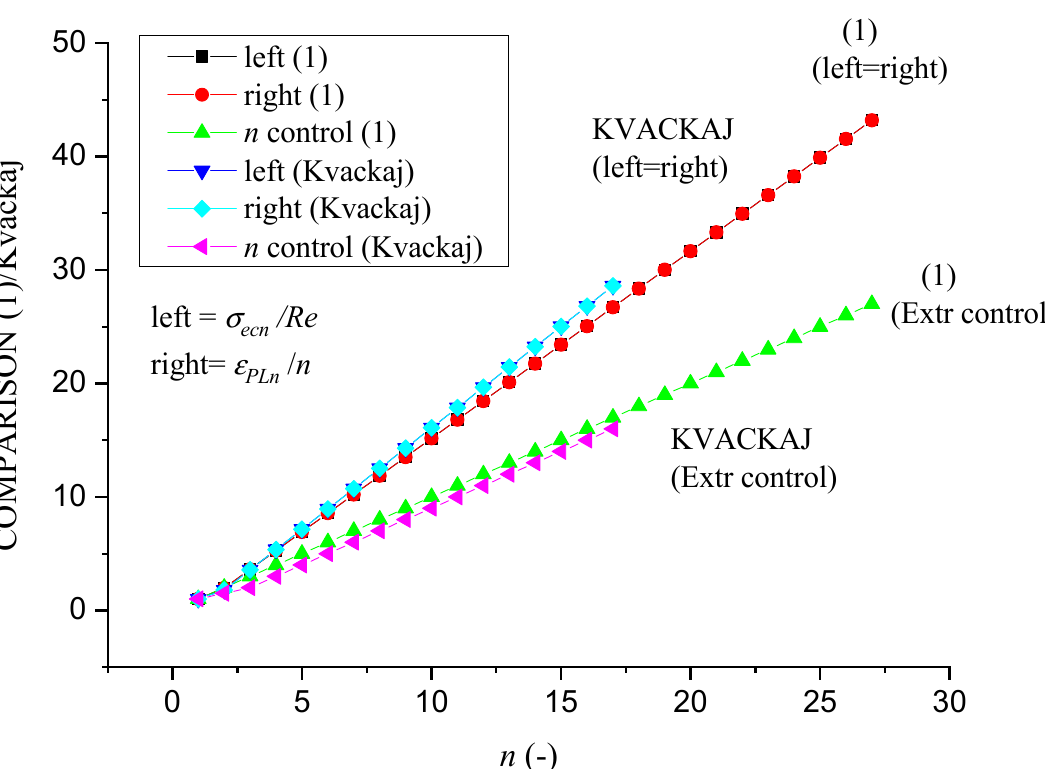
Figure 14. Comparison of data from our equilibrium equation with measured data by Kva č kaj.